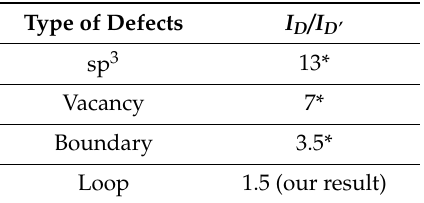
Table 3. I D / I D’ ratio value as a function of the type of defects. * values correspond to the work by Eckmann et al. [31].